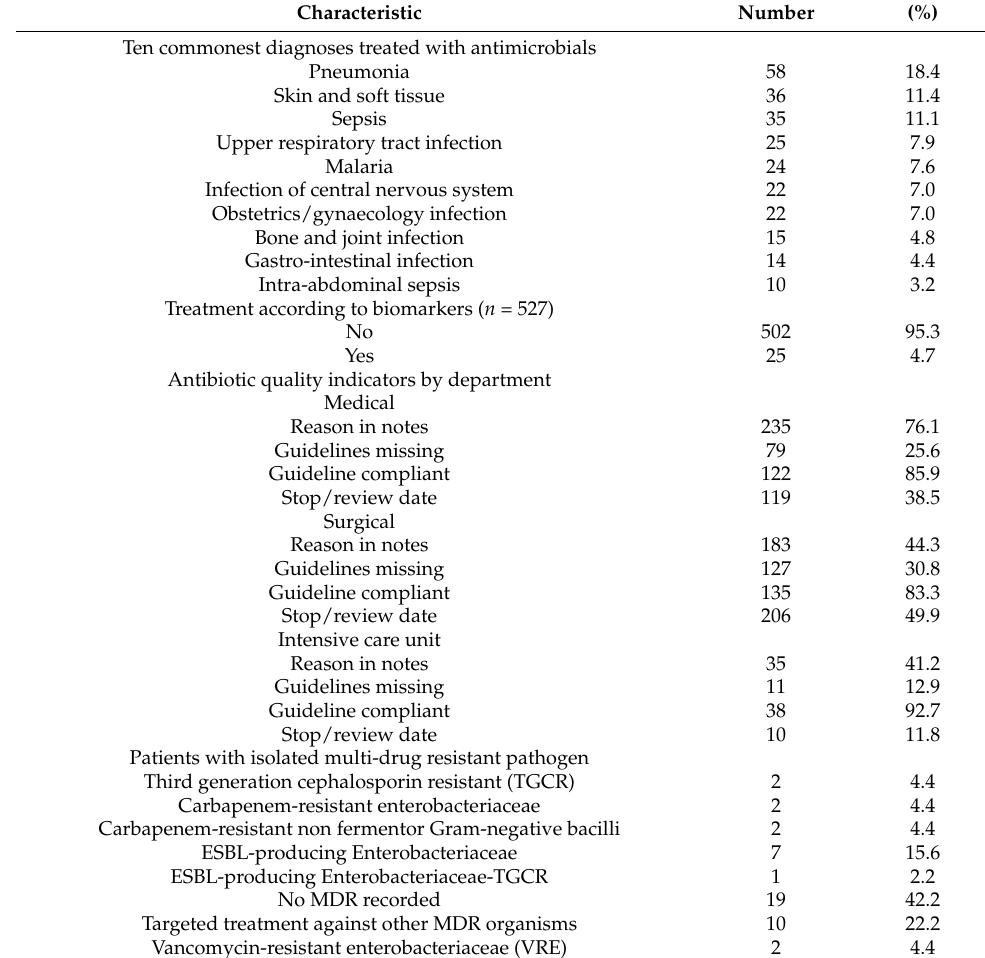
Table 4. Various characteristics of the PPS.